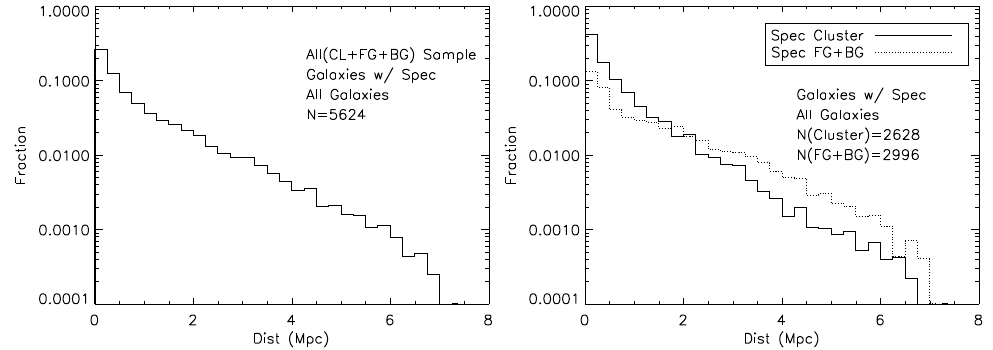
Figure 9. Total sample distribution as a function of cluster-centric distance ( left panel) and cluster membership assigned by spectroscopy ( right panel), both corresponding to our Subaru sample with available spectroscopy. ‘All’ sample means that cluster (CL), foreground (FG), and background (BG) galaxies are all combined. The number of galaxies in each distance bin is normalized by the total number of galaxies and corrected for by the search area of the bin, thus an unbiased sample should show a flat distribution with respect to the cluster-centric